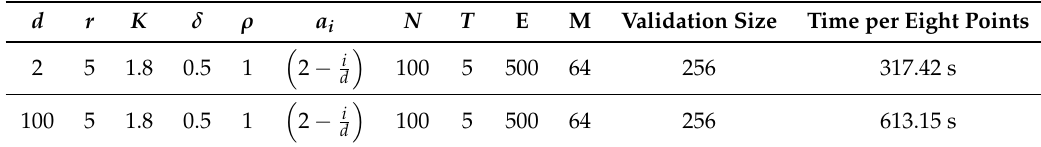
Table 3. Parameters for the dividend problem.